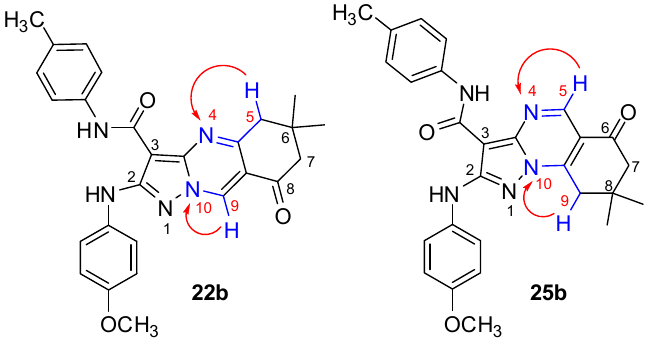
Figure 3. Diagnostic correlations in the 1 H- 15 N HMBC spectrum for the two isomers 22b and 25b.